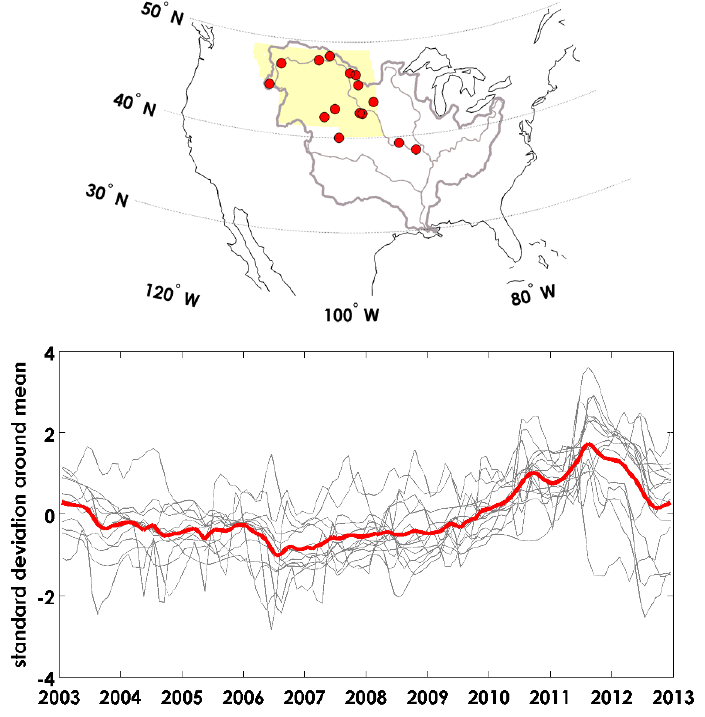
Figure 2. USGS well observation locations and normalized time series (grey lines), as well as the average of the normalized time series (red